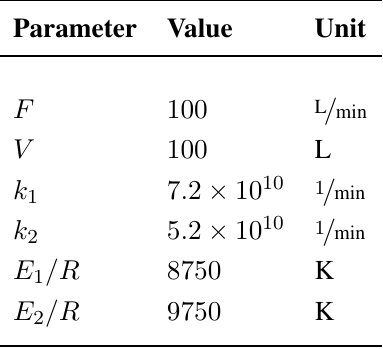
Table 2. Continuously-stirred-tank reactor (CSTR) parameters taken from